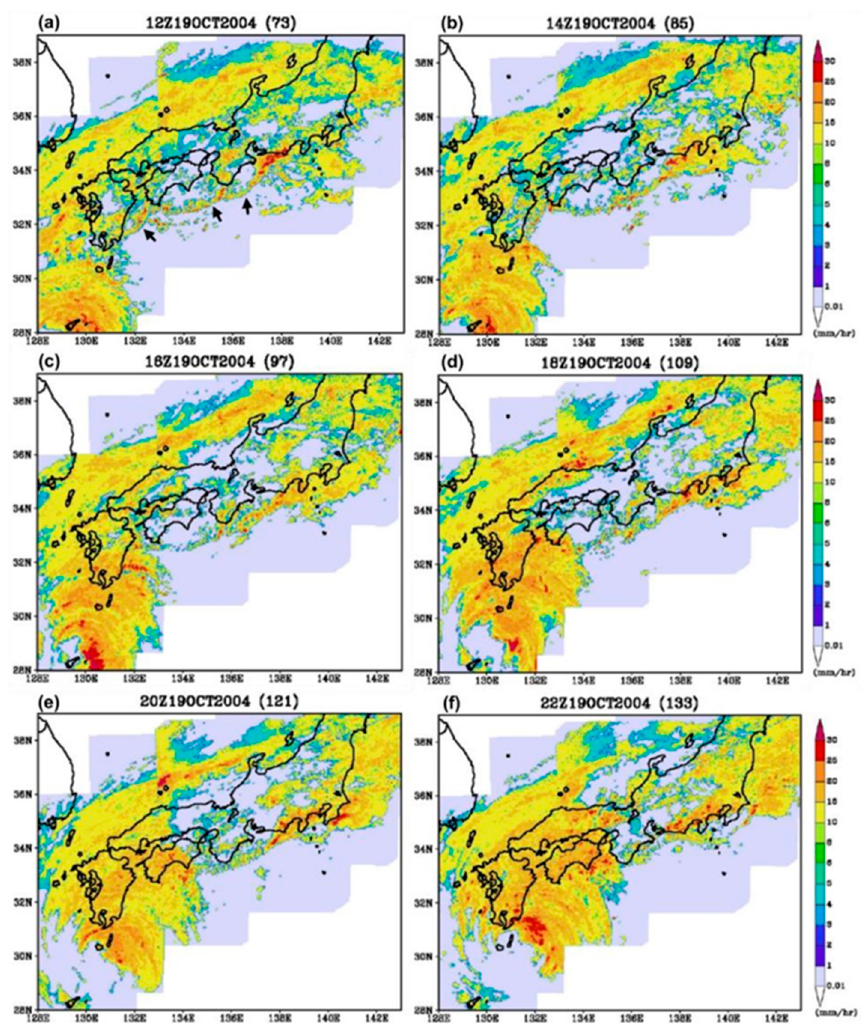
Figure 3. The rainfall intensity (mm h − 1 ) derived from the JMA radar reflectivity at 2-h intervals from at ( a ) 1200 to ( f ) 2200 UTC, 19 October 2004. The color scales are plotted to the right. The arc-shaped rainbands are marked by arrows in ( a ).